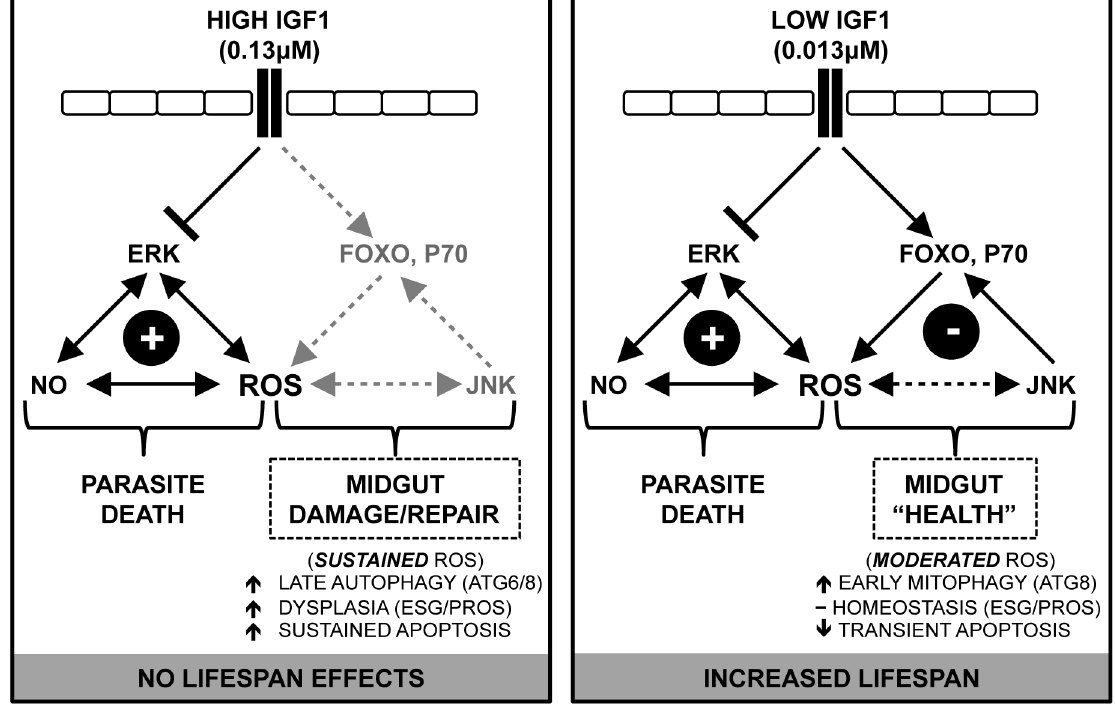
Figure 8. Proposed model: IGF1 fine-tunes the balance of epithelial homeostasis and midgut integrity, enhancing survival and anti- parasite resistance in A.stephensi . Human IGF1 in the midgut initiates signaling cascades that repress phosphorylation of ERK, enhancing midgut RNOS that induce parasite death. Low IGF1 acts through FOXO, JNK and P70S6K to induce JNK/IIS-mediated cytoprotective responses that moderate levels of ROS and NO to initiate early mitophagy, transient apoptosis, and ISC homeostasis, which increase mosquito survivorship. In contrast, high IGF1 does not activate JNK/IIS compensatory signaling, resulting in delayed autophagy and sustained RNOS, which drive damage-associated apoptosis and midgut epithelial dysplasia.